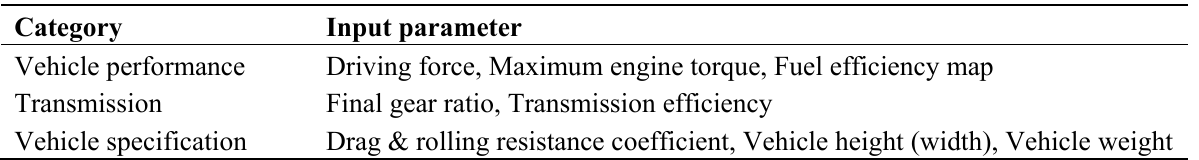
Table 8. The categorization of main input parameters impact on HDV fuel